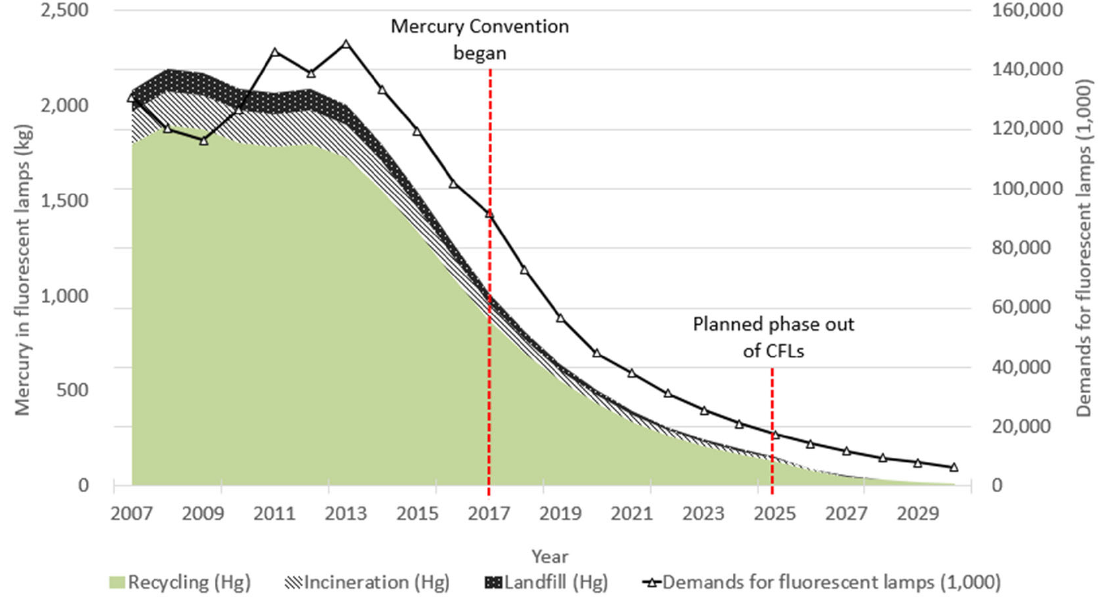
Figure 7. The result of dynamic flow of mercury in end-of-life fluorescent lamps in South Korea between 2007 and 2030.